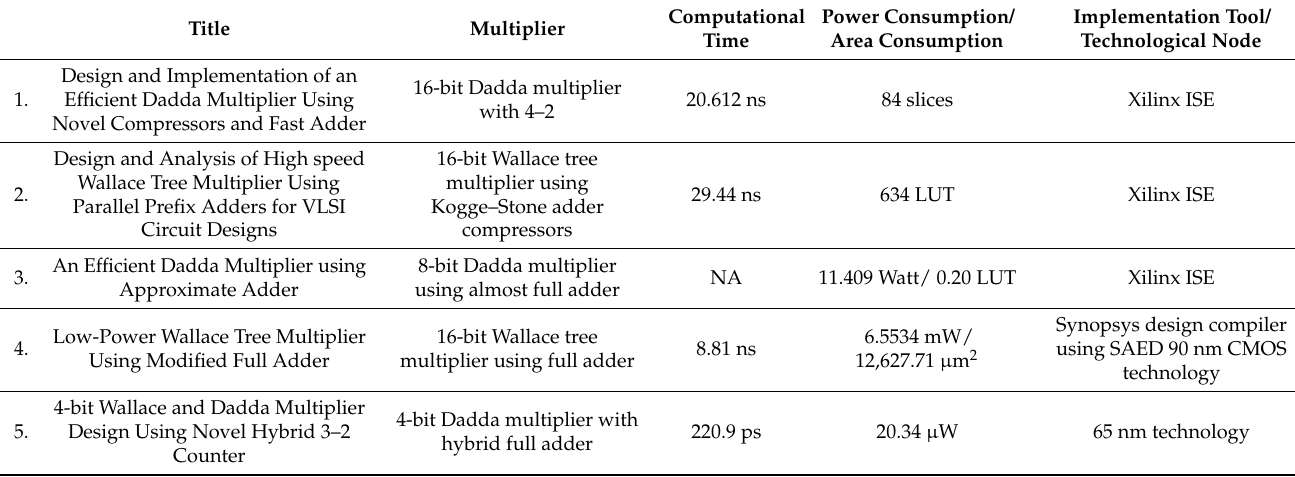
Table 1. Comparison of parameters of different existing literature